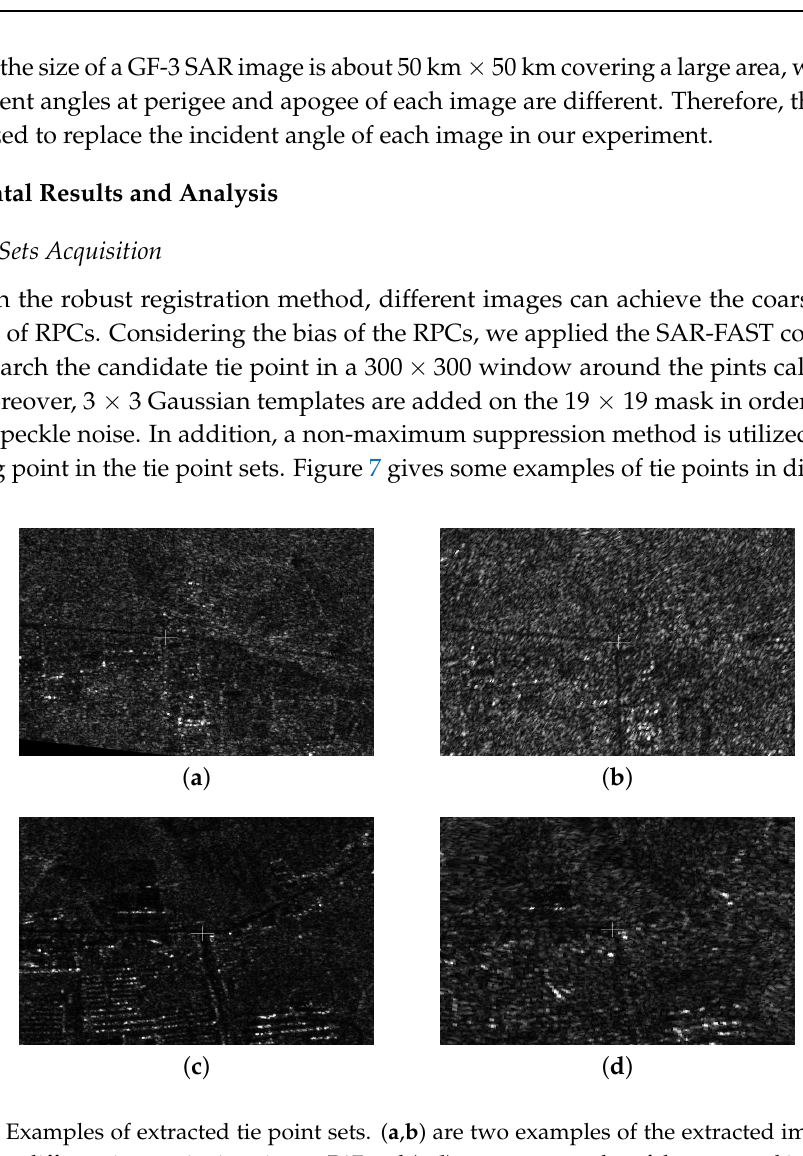
Figure 7. Examples of extracted tie point sets. ( a , b ) are two examples of the extracted image-space points from different images in tie point set P17 and ( c , d ) are two examples of the extracted image-space point from different images in tie point set P21, where the centers of the crosses are the extracted image-space point correlated with the object in